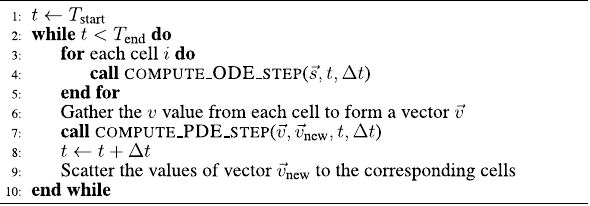
Algorithm 3. Operator-splitting skeleton for the simulation scenario (outer loop over